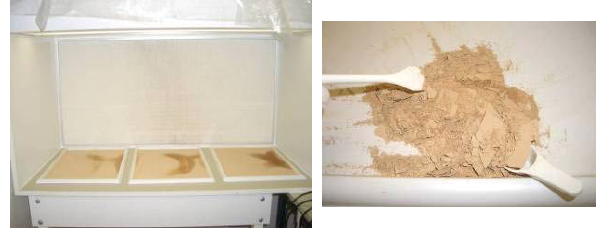
Fig. 6. Artificial aging of the atmospheric particles. The principle Figure 6 is to quickly evaporate a water-aerosol mixing in the typical pro- portions of a cloud drop that is deposited on ultraclean polypropy- lene plates under clean air within a laminar flow bench. Water is amended with substances normally observed in Mediterranean ma- rine atmosphere. The added aerosols are the finest fractions of the dust collected in Tunisia. The evaporation leads to a pH gradient in the system induced by proton concentration related to decrease in water volume, exactly as it occurs inside a cloud (photo S.